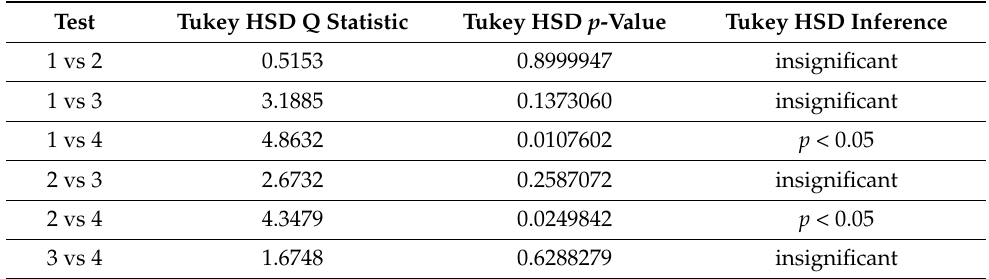
Table 7. Nausea SSQ score Tukey HSD results.